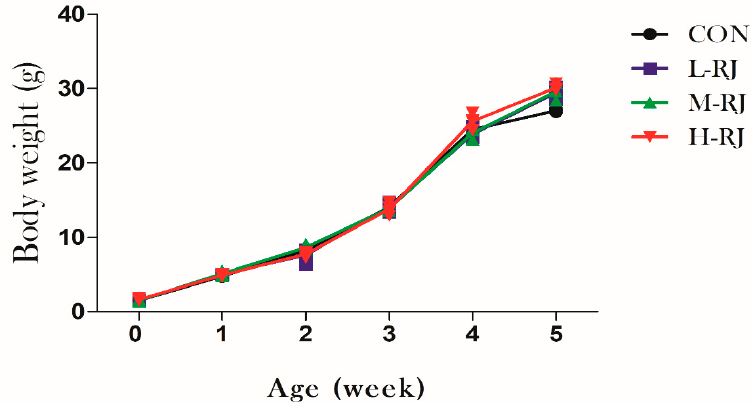
Figure 3. The effects of freeze-dried RJ on male mice body weight are shown in Figure 1. “CON” means the control group, “L-RJ”, “M-RJ” and “H-RJ” are the abbreviation of “low dosage of RJ”, “moderate dosage of RJ” and “high dosage of RJ”,